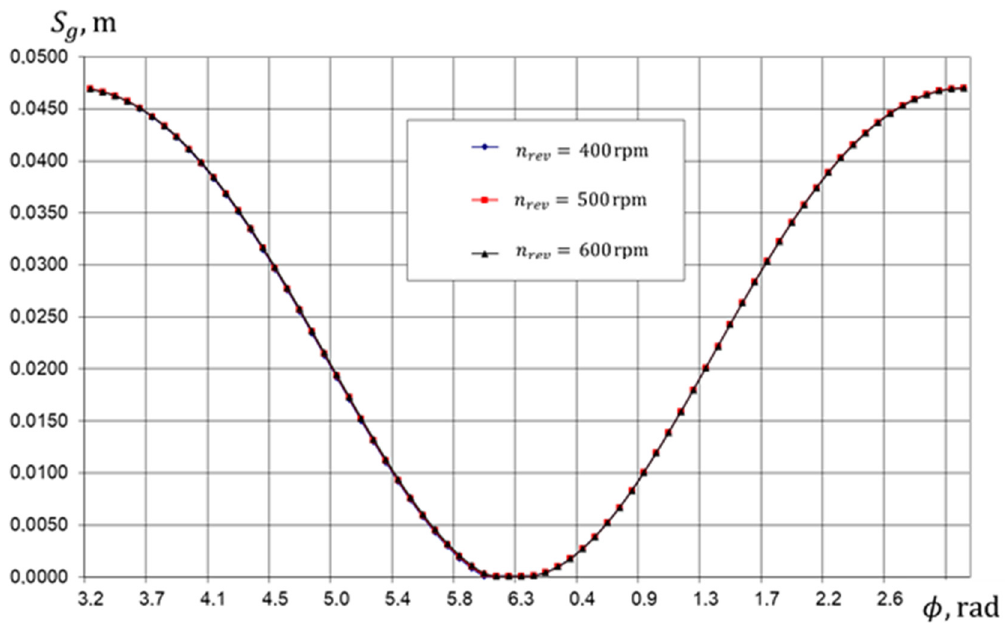
Figure 24. Dependence of the height of the gas volume of the compressor section on the angle of rotation of the crankshaft at different speeds.